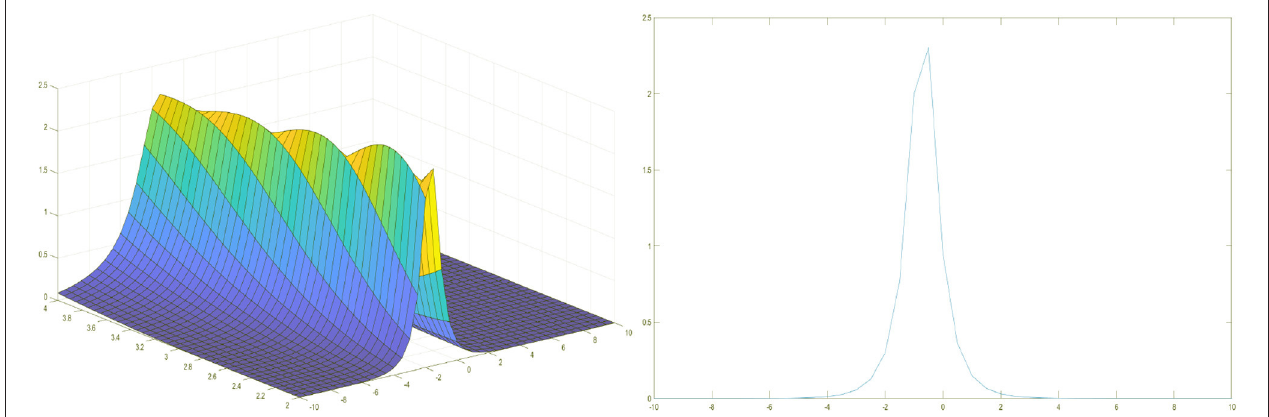
FIGURE 5 | Solitary wave solution of the loaded Gardner equation for k